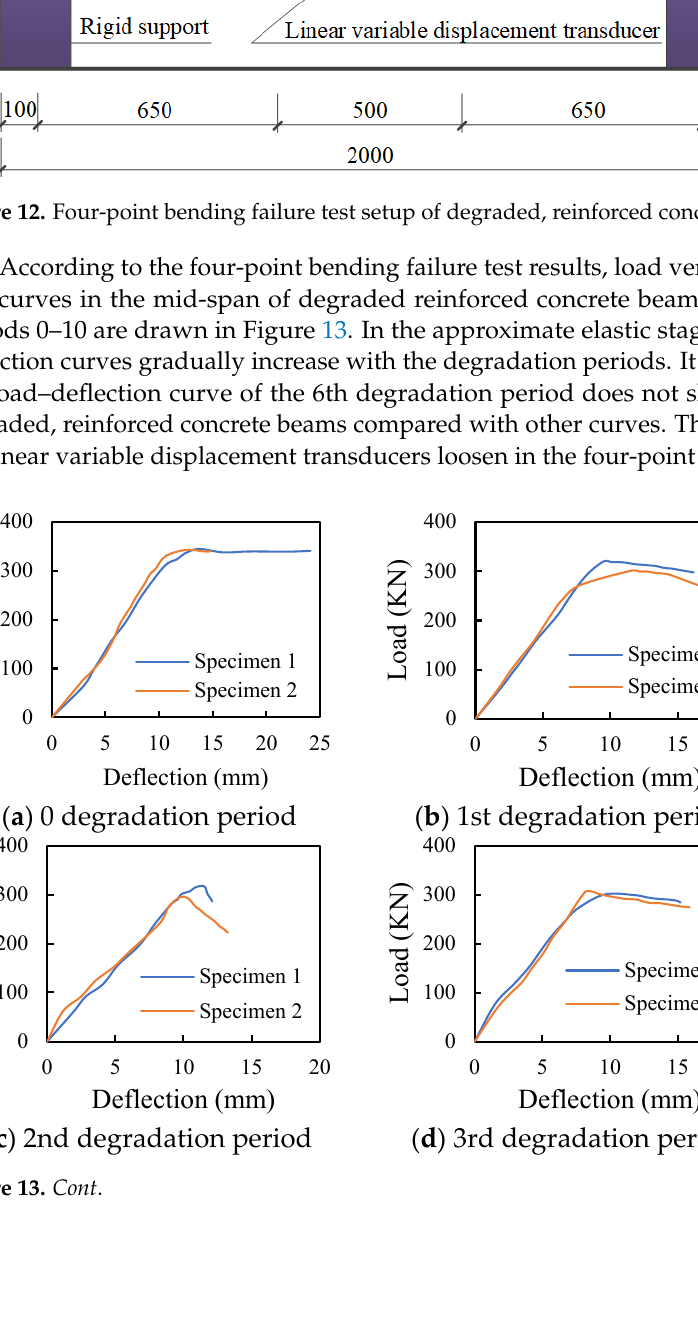
Degradation period Longitudinal steel bars with diameter of 14 mm Longitudinal steel bars with diameter of 16 mm Longitudinal steel bars with diameter of 18 mm